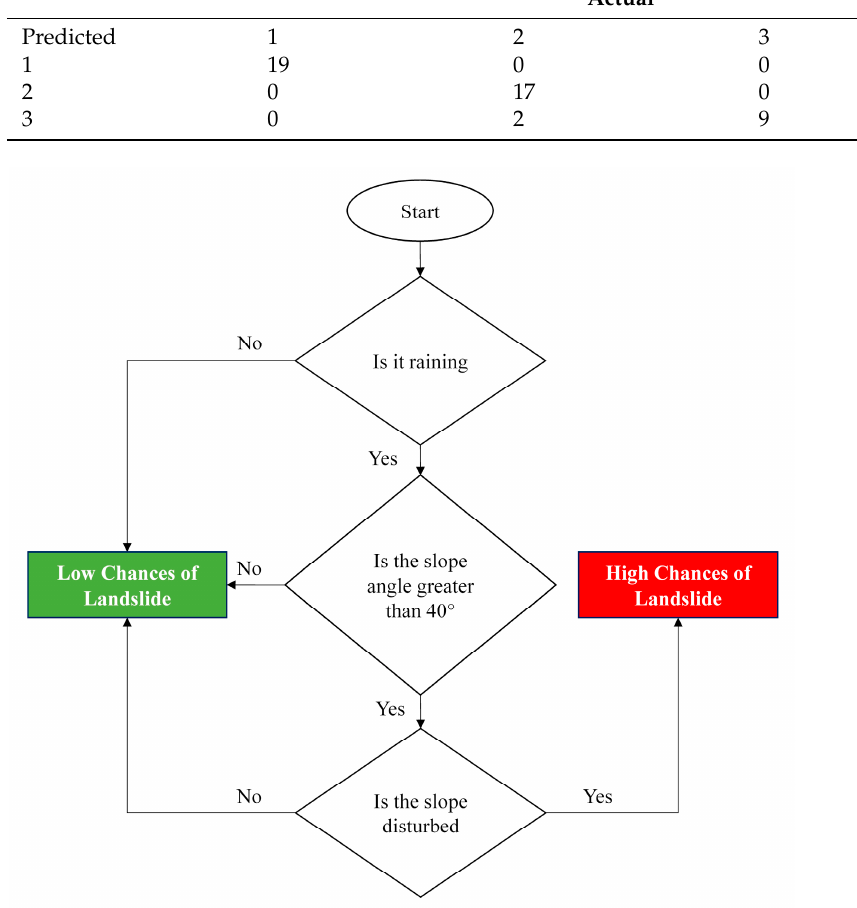
Figure 10. Conceptual algorithm flowchart of the decision tree algorithm for modelling the landslide chances. Table 9. Confusion matrix for the decision tree algorithm used in assessing the best algorithm for the LEWS (Training data).